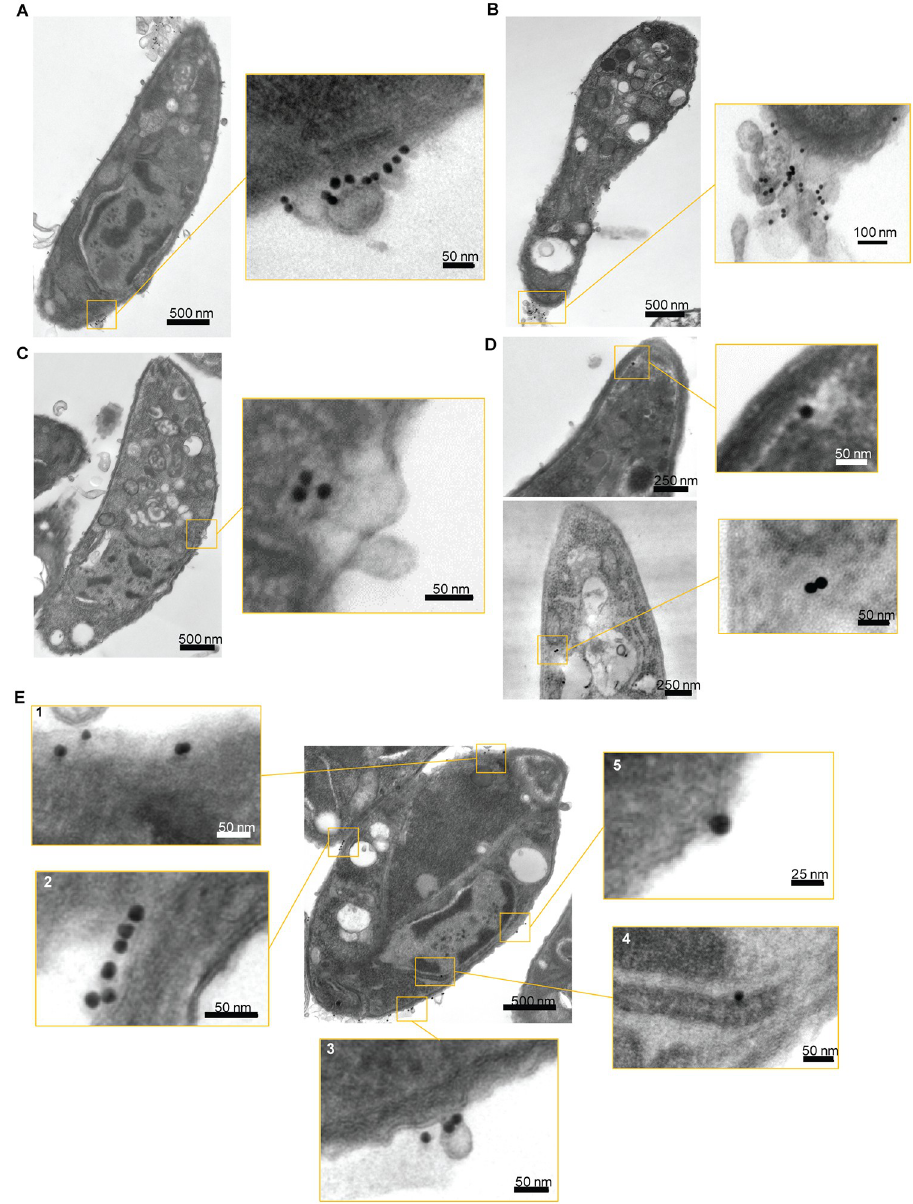
Fig 7. SAG1 uptake analysed by TEM. Uptake of SAG1 was also analysed by TEM. Secondary antibodies were coupled with 15-nm gold beads to label the parasites before incubation at 37 ˚C with Tf-LPA. (A-D) The three different labels observed by immunofluorescence assays (Fig 6) were also observed by TEM. (A) Parasite with α SAG1 bound to the membrane. (B) Parasite with α SAG1 capped. (C-D) Parasite with α SAG1 endocytosed at different locations. As for the NGP, the gold-coupled antibodies seem to be in translucent vesicles. (E) Transversal cut of a parasite, illustrating that labelling in different parts of the parasite can be observed at the same time even in TEM. Five close-up images are showing the different types of interactions. (1) Beads below the plasma membrane, (2) beads at the surface of the plasma membrane, (3) beads located on a budding vesicle, (4) bead located near the ER, (5) bead in very tight interaction with the membrane. ER, endoplasmic reticulum; NGP, nanogold particle; TEM, transmission electron microscopy; Tf-LPA, Top-Fluor lysophosphatidic acid.